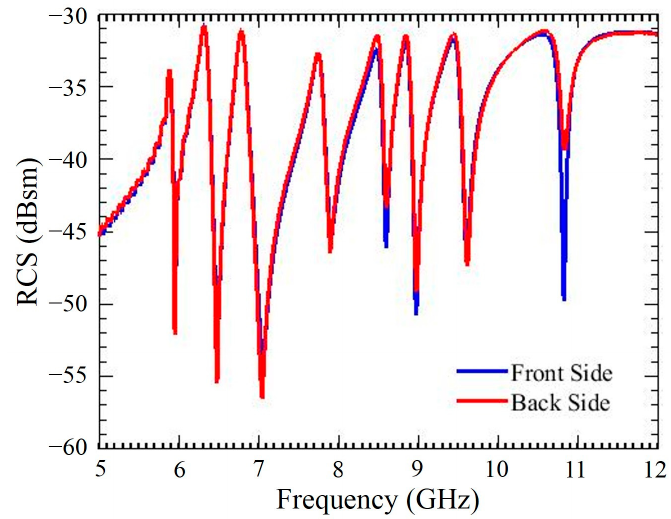
Figure 13. Simulated RCS response of proposed tag when illuminated from either front or back side.